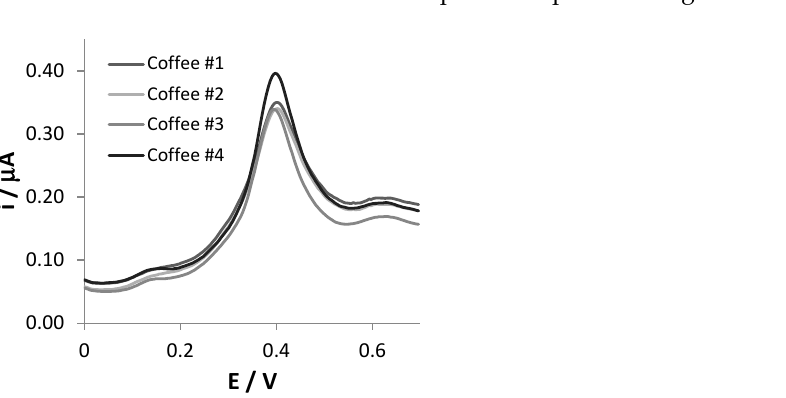
Figure 3. DPV scans recorded at SNGC-CB electrodes in coffee samples, diluted 1:16 in 0.1 M AB pH = 4.0 solution.